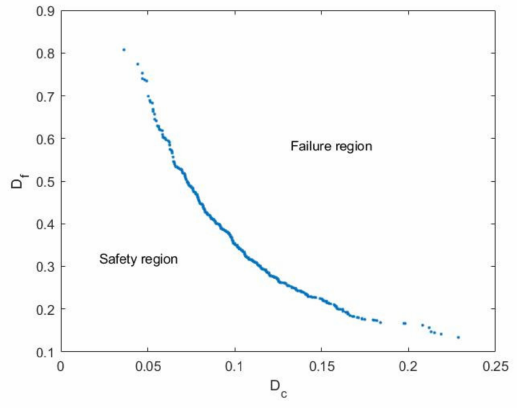
Figure 10. Creep-fatigue failure function.